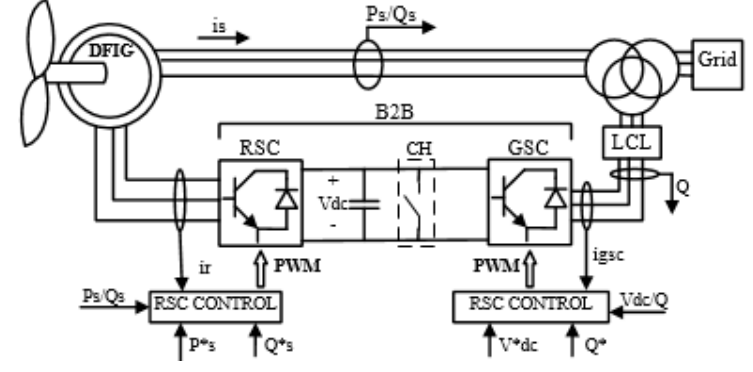
Figure 1. DFIG structure with the controllers.